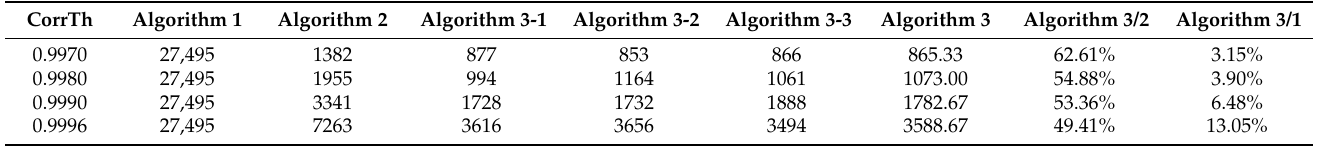
Figure 3. Comparison of the three compression algorithms based on data selection: ( a ) The number of correlation coefficient calculations. ( b ) The number of selected bands of the three algorithms under different correlation coefficient thresholds. The specific values when the correlation coefficient thresholds are 0.997, 0.998, 0.999, and 0.9996 are presented in Tables 2 and 3. Table 2. The number of correlation coefficient calculations of the three algorithms under four selected correlation coefficient thresholds.